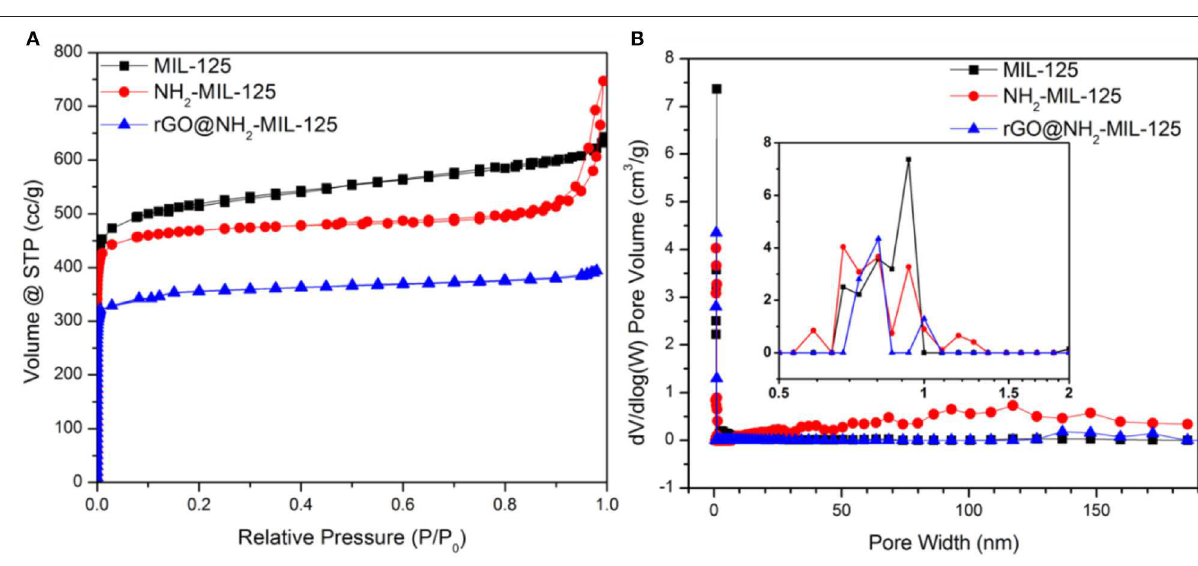
FIGURE 3 | Nitrogen adsorption–desorption isotherms (A) and the corresponding pore size distribution curves (B) of MIL-125, NH 2 -MIL-125 and rGO@NH 2